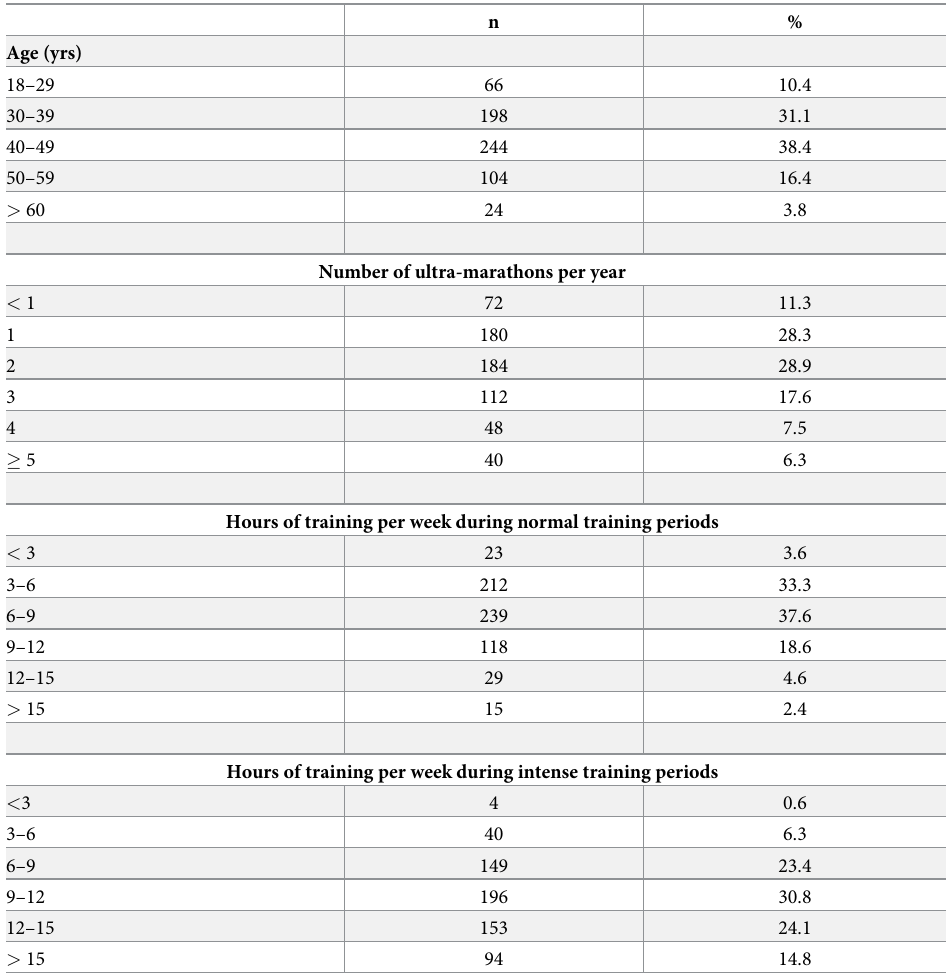
Table 1. Selected characteristics of the